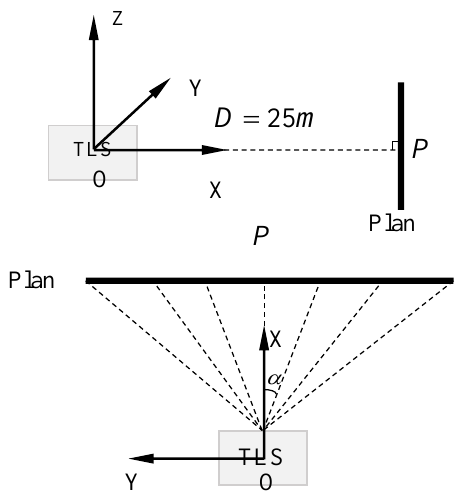
Figure 1. Establishment of the monitoring coordinate system, where O is the laser origin of the scanner,  is the incidence angle of the laser point on the plane.